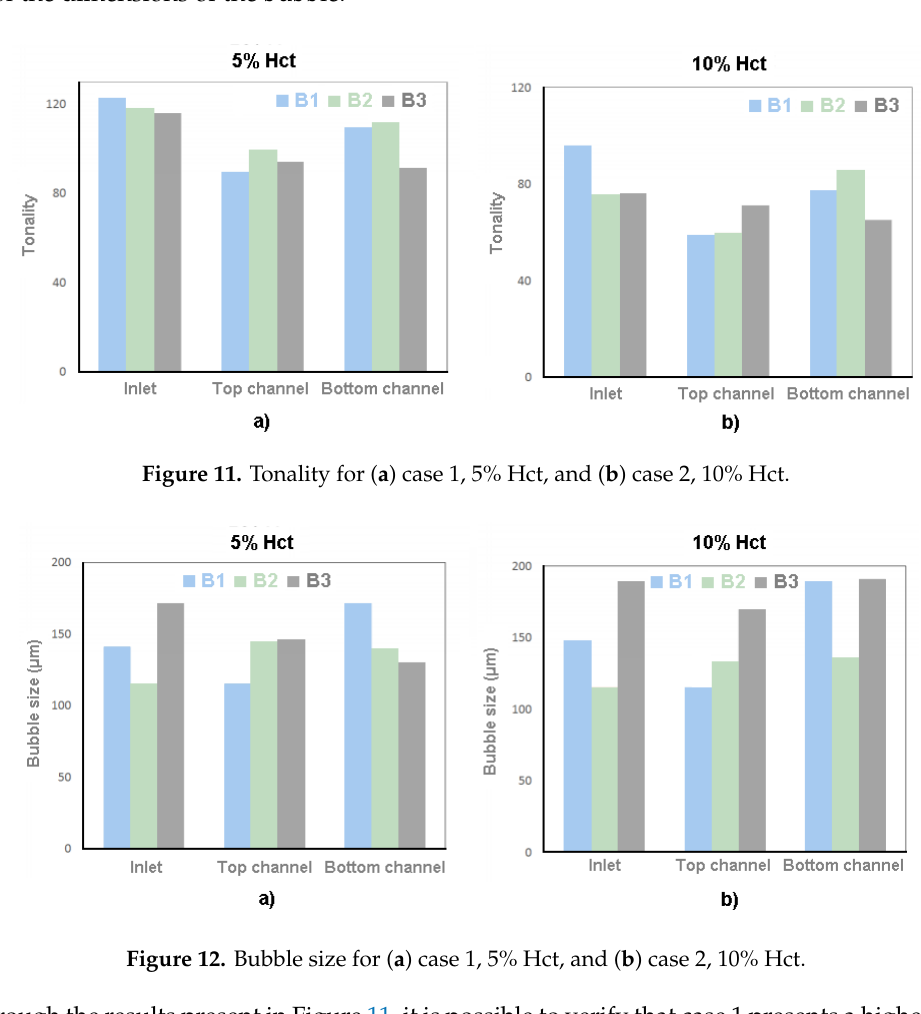
Figure 11. Tonality for ( a ) case 1, 5% Hct, and ( b ) case 2, 10% Hct.